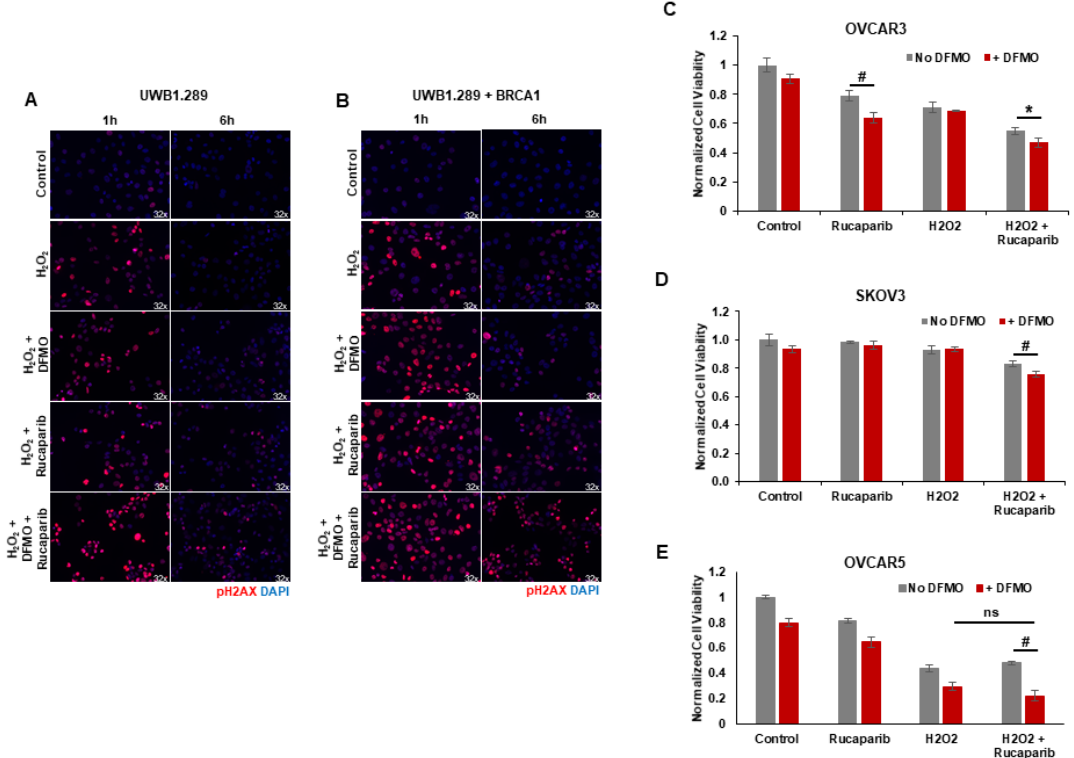
Figure 3. DFMO and rucaparib treatment increases H 2 O 2 -induced DNA damage in ovarian tumor